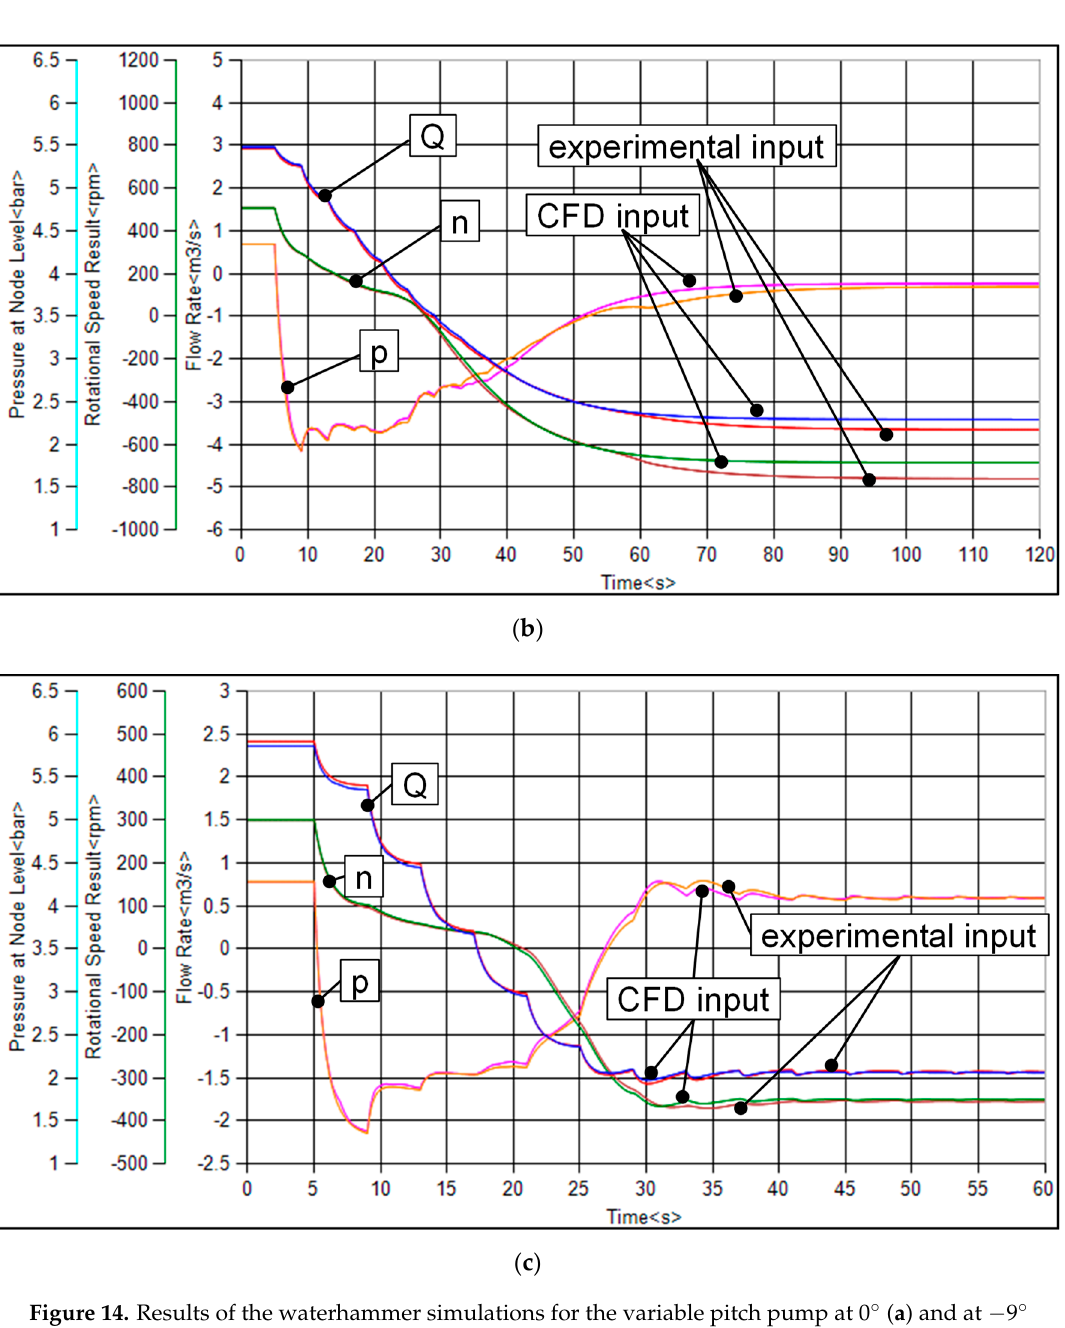
Figure 14. Results of the waterhammer simulations for the variable pitch pump at 0° ( a ) and at − 9° pitch angle ( b ) as well as for the low n q pump ( c ).